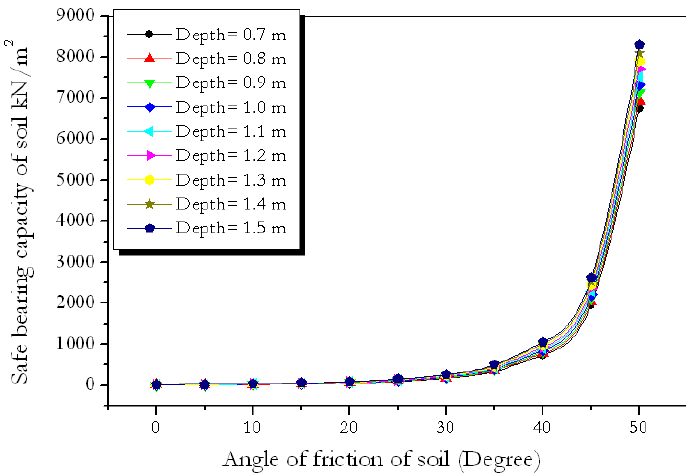
Figure 3: Safe bearing capacity Vs angle of friction of soil